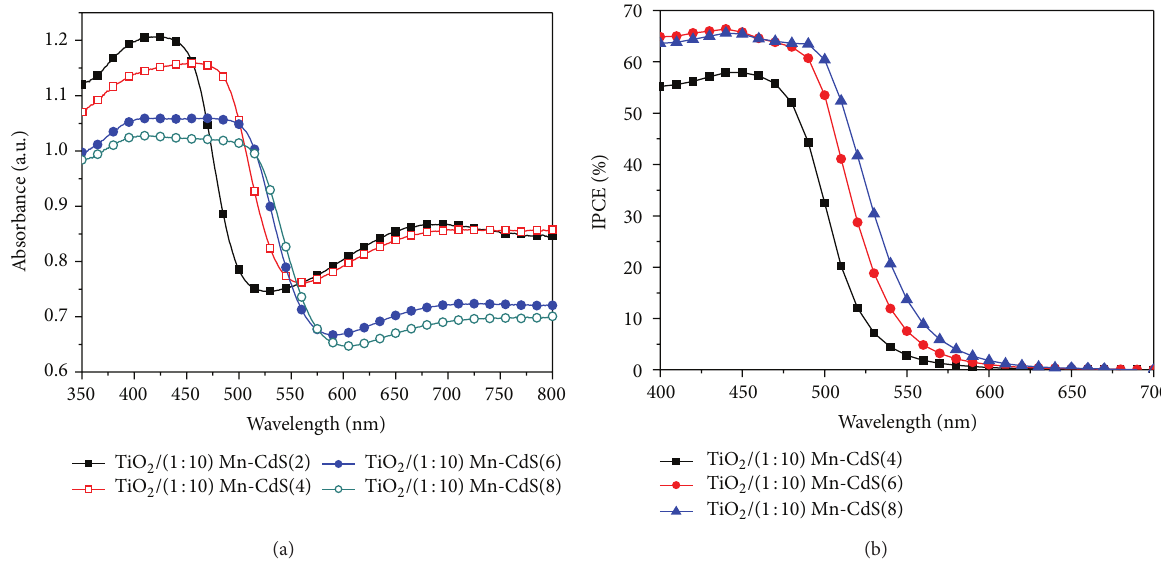
Figure 5: (a) UV-Vis absorption spectra and (b) IPCE spectra of mesoscopic TiO 2 photoanode deposited by different SILAR cycles of Mn- doped-CdS QDs.